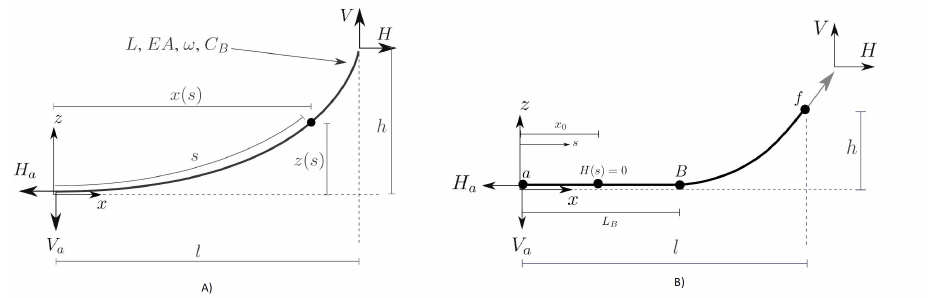
Figure 5. Scheme of line configuration. ( A ) suspended chain ( B ) bottom contact